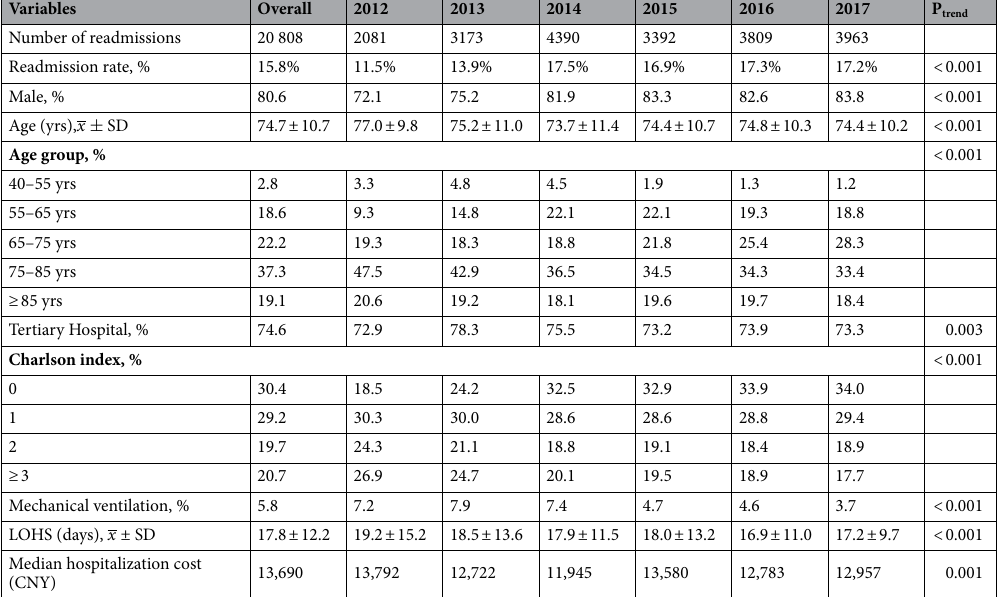
Table 1. Characteristics of 30-day readmitted patients during 2012–2017 (n = 20 808). All costs were adjusted for the increment of inflation. LOHS , length of hospital stay, CNY Chinese